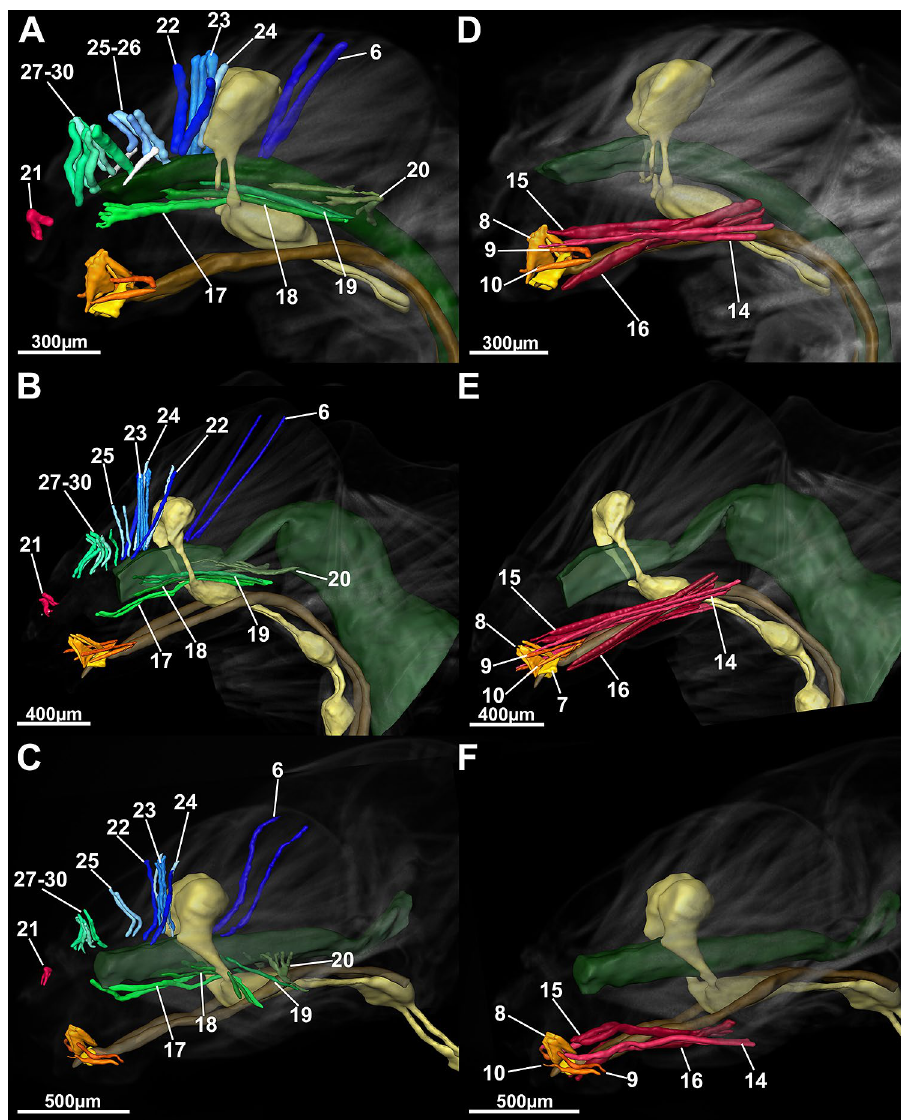
Figure 6. Lateral view of 5th instar larvae of Drusus discolor ( A , D ), D. bosnicus ( B , E ) and D. franzi ( C , F ) based on µCT data. Abbreviations: 6 = Musculus (M.) cranio-postpharyngalis dorsalis, 7 = M. praemento- salivaris, 8 = M. hypopharyngo-salivarialis, 9 = M. basistipito-dististipitalis lateralis, 10 = M. basistipito- dististipitalis medialis, 14 = M. cranio-dististipitalis, 15 = M. cranio-praementalis anterior, 16 = M.